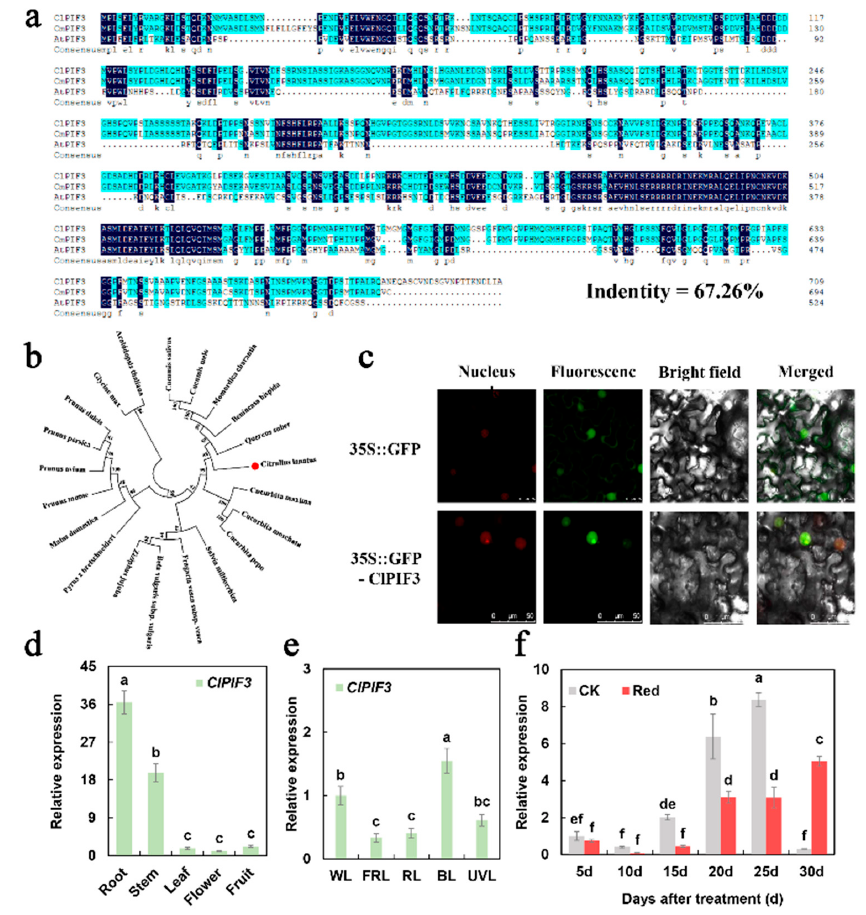
Figure 4. Sequence alignment, phylogenetic analysis, subcellular localization, and expression pattern of the ClPIF3 gene. ( a ) Amino acid sequence alignment of ClPIF3, CmPIF3, and AtPIF3. The sequence in black shadow represents the same sequence ( b ) Phylogenetic tree of ClPIF3 with other PIF3 proteins from different plant species. ( c ) Subcellular localization of ClPIF3 in N. benthamiana leaf cells and the green dots are GFP fluorescent protein. Bars = 25 µ m. ( d ) The expression levels of ClPIF3 in different tissues. ( e ) Responses of ClPIF3 in leaves to different types of light. WL, white light; FRL, far-red light; RL, red light; BL, blue light; UVL, UV light. ( f ) Response of ClPIF3 to supplementary red lighting treatment during fruit development. The data showed mean values of three replicates ( ± SD) with three plants per replicate. The mean values of different letters were significantly different ( p <